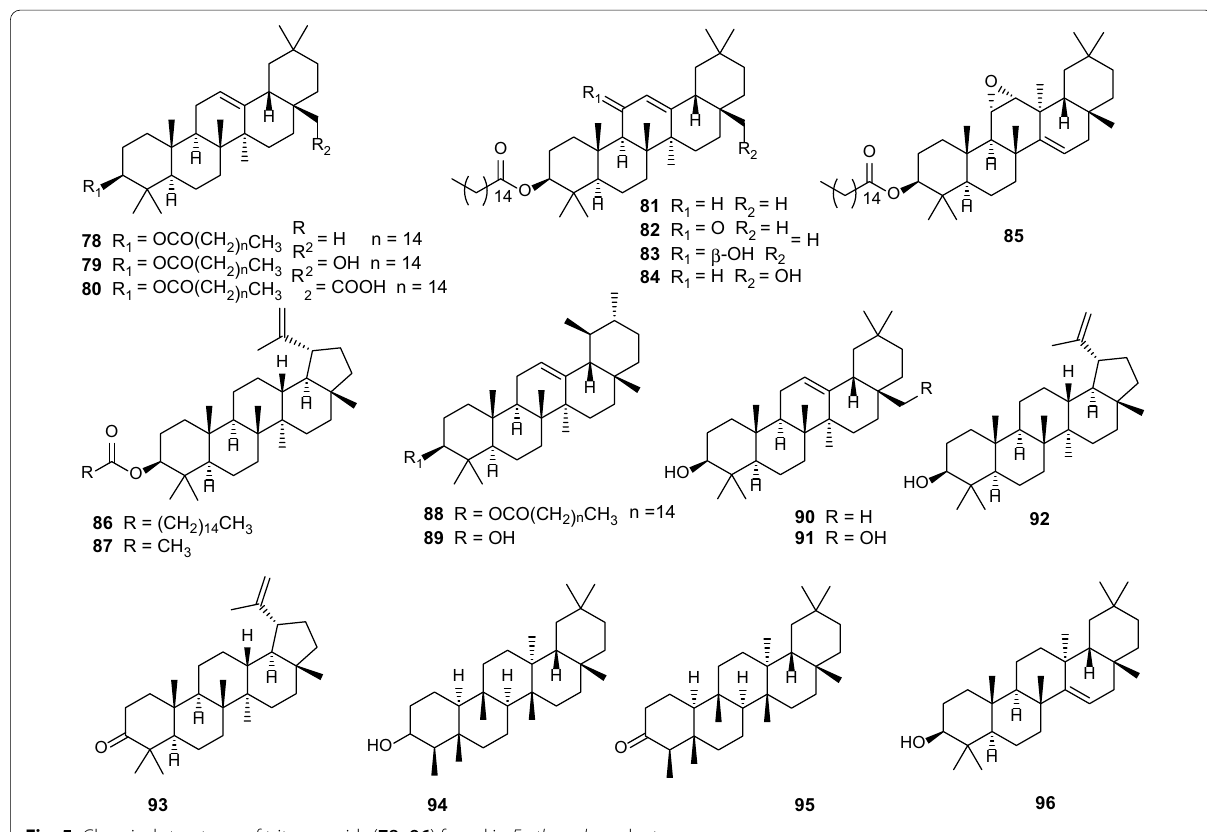
Fig. 5 Chemical structures of triterpenoids ( 78–96 ) found in Erythroxylum plants